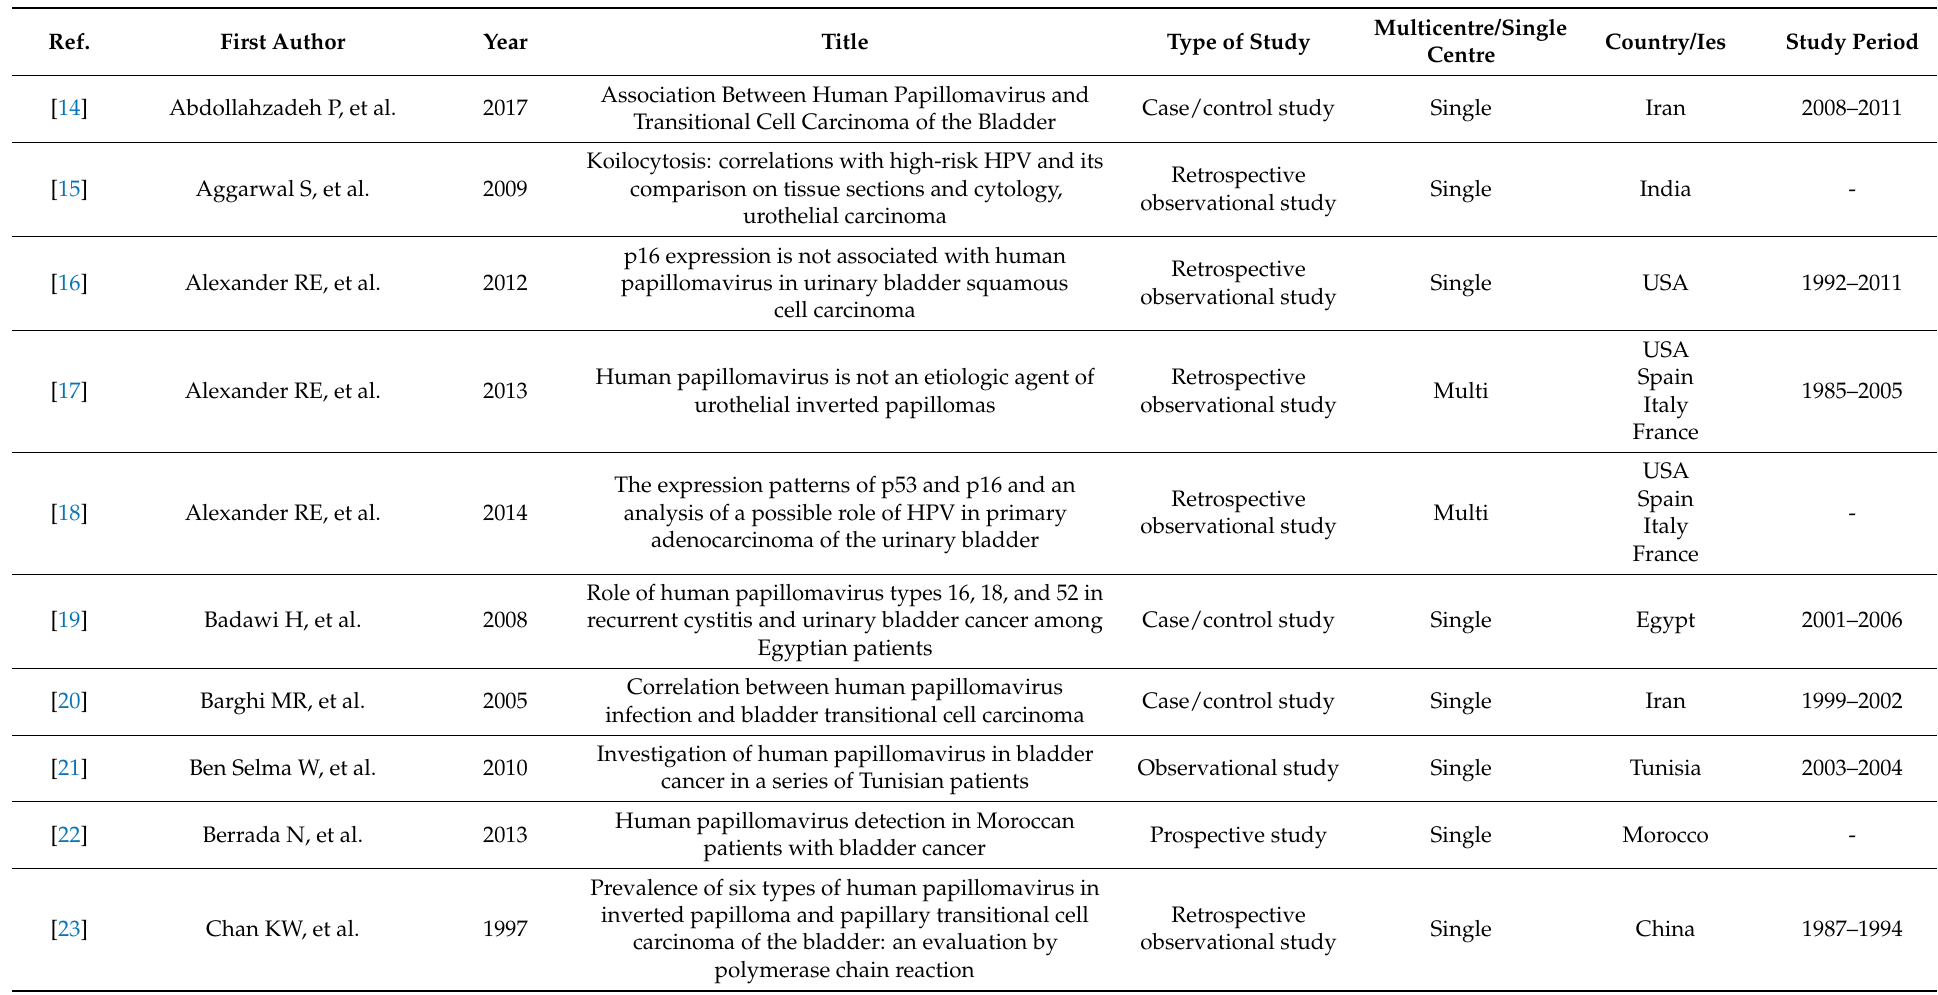
Table 1. Characteristics of the included studies (n =